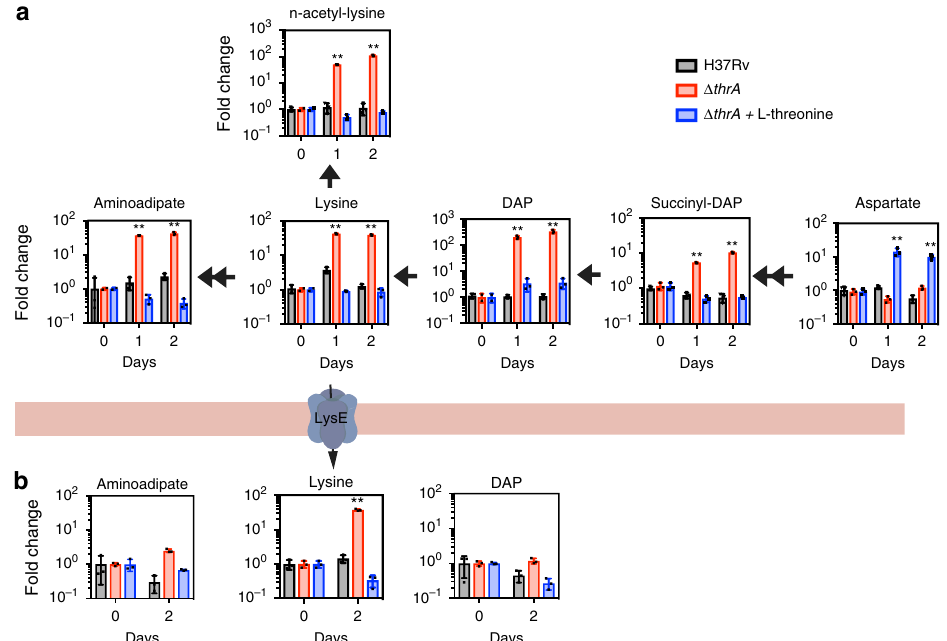
Fig. 3 Endo and exometabolome of Mtb Δ thrA . a Starvation of the homoserine auxotroph Mtb Δ thrA in unsupplemented medium (red bars) leads to strong (up to 100-fold) intracellular accumulation of lysine and DAP and its biosynthetic intermediates, as well as downstream metabolites aminoadipate, and n- acetyl-lysine. Accumulation of the same intermediates is not observed in WT cells ( Mtb H37 Rv ) under the same conditions (black bars). Addition of threonine to Mtb Δ thrA reverses accumulation of lysine and its intermediates (blue bars). Under the same conditions, aspartate but no other intermediate accumulates indicating that aspartate kinase is feedback inhibited by threonine. b Analysis of the exometabolome shows accumulation of lysine but no other intermediate in the supernatant of unsupplemented Mtb Δ thrA (red bars) . Threonine addition stopped lysine export (blue bars). All values are the average of three biological replicates ( n = 3) ±s.d. (error bars depict standard deviation) and are representative of a minimum of two independent experiments. ** p -value < 0.01 in Student's t -test. Bars are overlaid with dot plot of individual values. Source data are provided as a Source Data fi le